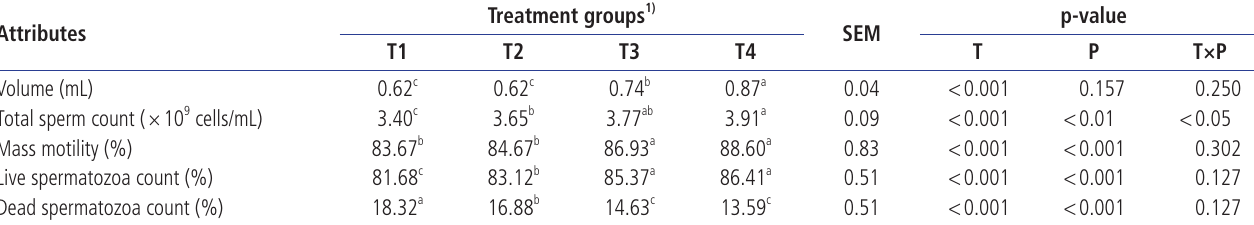
Table 4. Effect of soapnut shell powder supplementation on physical characteristics of semen